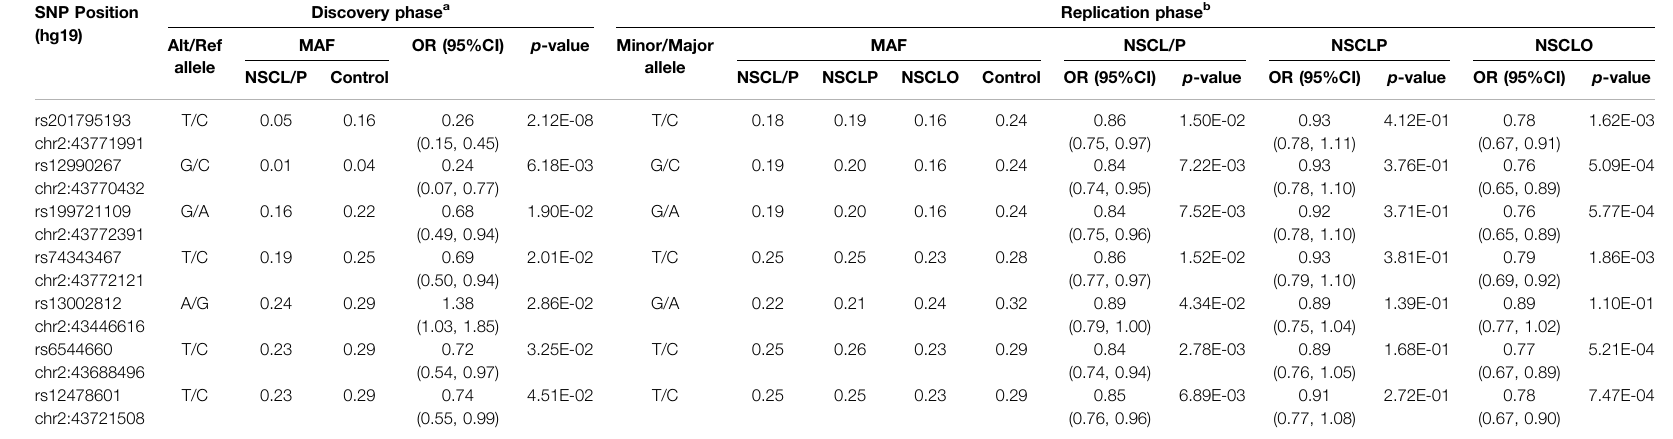
TABLE 1 | Allelic association analysis for the SNPs in 2p21